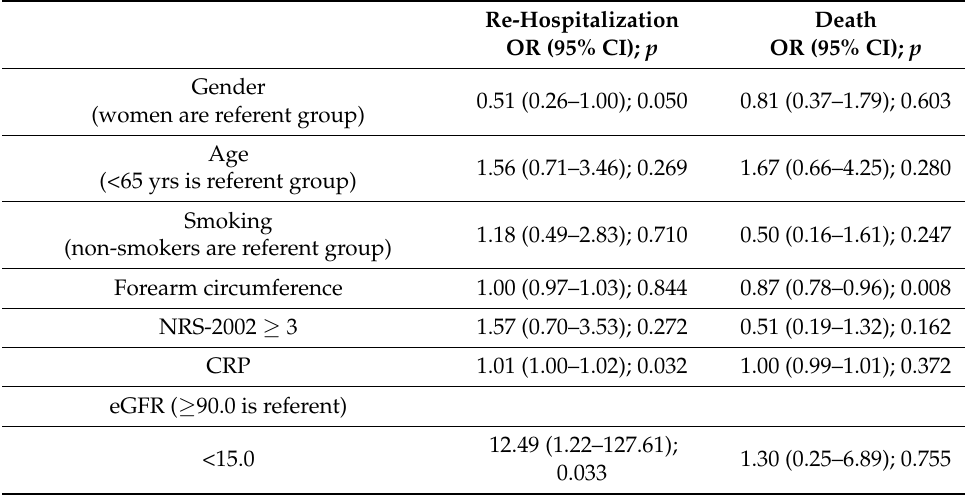
Table 4. Risk factors for death outcome and re-hospitalization during follow-up, n = 218 (binary logistic